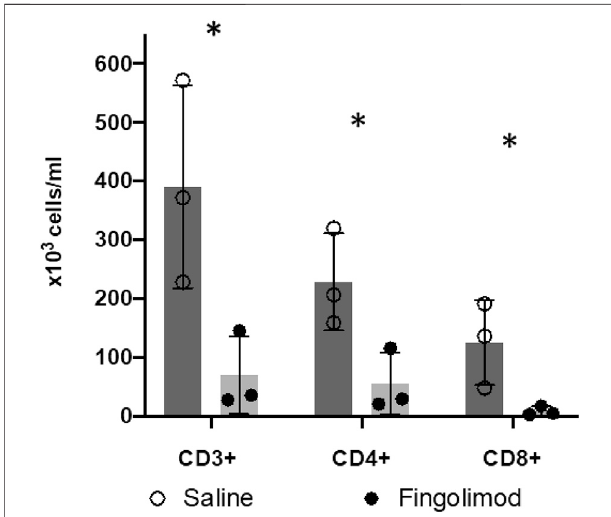
FIGURE 5 | Fingolimod caused a signi fi cant drop in blood lymphocyte counts. ( ○ ) male saline-treated, ( C ) male fi ngolimod-treated mice (mean ± SD).Mice(n (cid:1) 3pergroup)treatedfor3dayswith0.5 mg/kgof fi ngolimodhad a signi fi cantly lower CD3-, CD4-and CD8-positive lymphocyte count than mice treated with saline; * p <